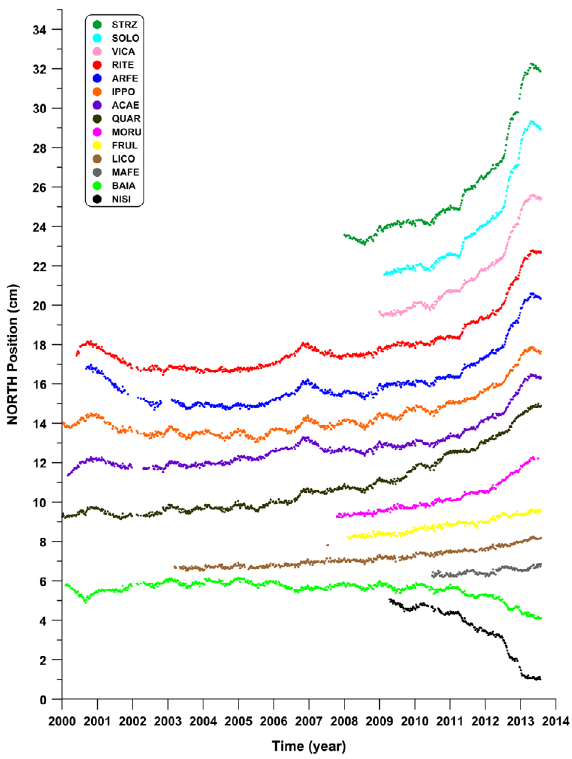
Clockwise from top left: Figure 2. GPS weekly time series of North component for CF stations relative to ENAV station. Uncertainties are not shown here, but are reported in data files (Supplementary material). Curves have been arbitrarily shifted for clarity. See Fig- ure 1 for the location of the GPS stations. Figure 3. GPS weekly time series of East component for CF stations relative to ENAV sta- tion. Uncertainties are not shown here, but are reported in data files (Supplementary material). Curves have been arbitrarily shifted for clarity. See Figure 1 for the location of the GPS stations. Figure 4. GPS weekly time series of Vertical component for CF stations. Un- certainties are not shown here, but are reported in data files (Sup- plementary material). Curves have been arbitrarily shifted for clarity. See Figure 1 for the location of the GPS